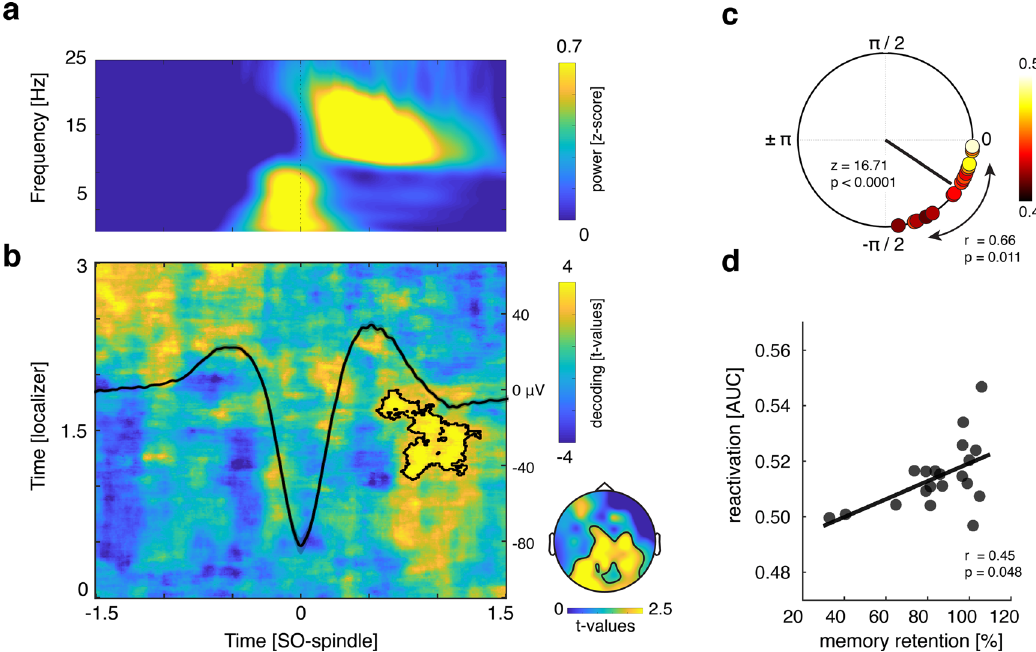
Fig. 2 SO-spindle locked memory reactivation. a Time – frequency representation of all SO-spindle segments ( z -scored across time; only positive values are displayed, with yellow indicating power increases). b Learning-related brain patterns (objects vs. scenes) were decodable during SO-spindle complexes (contour lines indicate the extent of the signi fi cant cluster, p = 0.016 corrected; color range (blue to yellow) represents t values against surrogate decoding performance, which was estimated by shuf fl ing the training labels 250 times). The averaged EEG trace (all instances in which SO downstates were followed by sleep spindles within 1.5 s at channel Cz in microvolt [ μ V]) illustrates the relationship of the observed reactivation signal with ongoing oscillatory activity. The topographical insert illustrates the results of a “ searchlight decoding procedure ” , indicating that bilateral parietal and occipital areas exhibited stimulus-category related effects (please note that statistical tests were done for illustrative purposes only). c Phases of the SO-spindle modulation derived from channel Cz, illustrating the clustering of spindle power toward the SO upstate (upstate corresponding to 0 and downstate to ± π , with – π /2 re fl ecting the down- to upstate transition; Rayleigh test: p < 0.0001; z = 16.71). The black line illustrates the mean coupling direction and vector length ( − 36.78° ± 5.48°, mean vector length = 0.91). Circular-linear correlation analysis between the individual mean SO-spindle coupling phase (circles) and the mean reactivation strength (area under the curve [AUC] scores; color coded, with white indicating high classi fi cation performance and black low classi fi cation performance) revealed a positive association ( r = 0.66; p = 0.011). d Reactivation strength correlated positively with behavioral levels